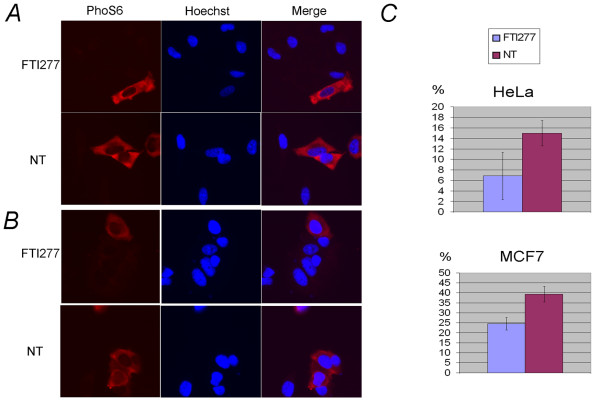
FTI-277 treatment reduces the phosphorylation of ribosomal protein S6 in HeLa and MCF-7 cells. The levels of RPS6 (p70) phosphorylation in HeLa and MCF-7 cells were measured using the ScanR analysis software based on the intensity of AlexaFluor 555-conjugated PhoS6 antibody (Ser 235/236: Cell Signalling) recorded from images acquired from samples treated with 5 μM FTI-277 (panel FTI-277) or not treated (panel NT) in the presence of 0.1% serum for 24 h. Five wells per condition were considered. Cells were seeded in a 96-well plate and fixed and stained as described in Methods. Sixteen images were acquired randomly per well with a 20× objective using the RFP filter. The mean intensity within the red channel was automatically calculated by ScanR analysis software considering at least 600 cells. A, Images representative of FTI-277-treated and untreated HeLa cells stained with PhoS6 antibody and Hoechst, single and merged pictures are shown. B, Images representative of FTI-277-treated and untreated (NT) MCF-7 cells, stained as in (A); C, Analysis of the distribution of the phosphorylated RPS6 population in HeLa and MCF-7 cell lines. Hoechst staining was used for cell identification (main mask), as described in Methods. The minimal threshold of the PhoS6 signal was set at mean intensity 43.8 for HeLa and at 63.8 for MCF-7 cells based on the background intensity. The percentage of cells having a PhoS6 signal localised within this gate was calculated and plotted in the graph.